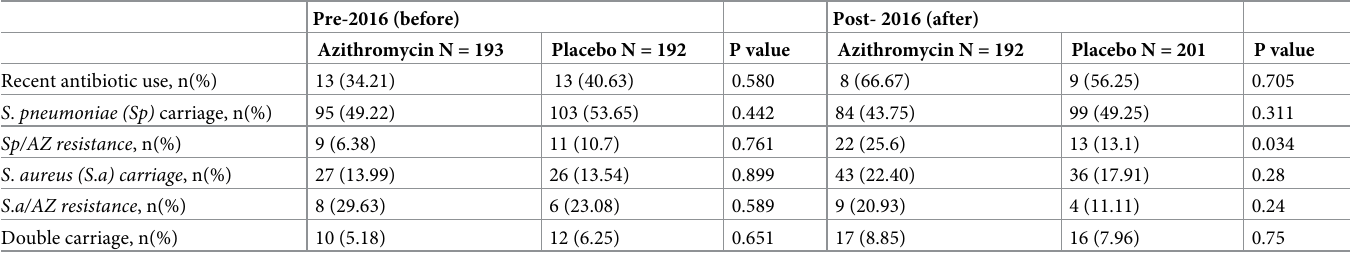
Table 2. Microbiological characteristics of the study